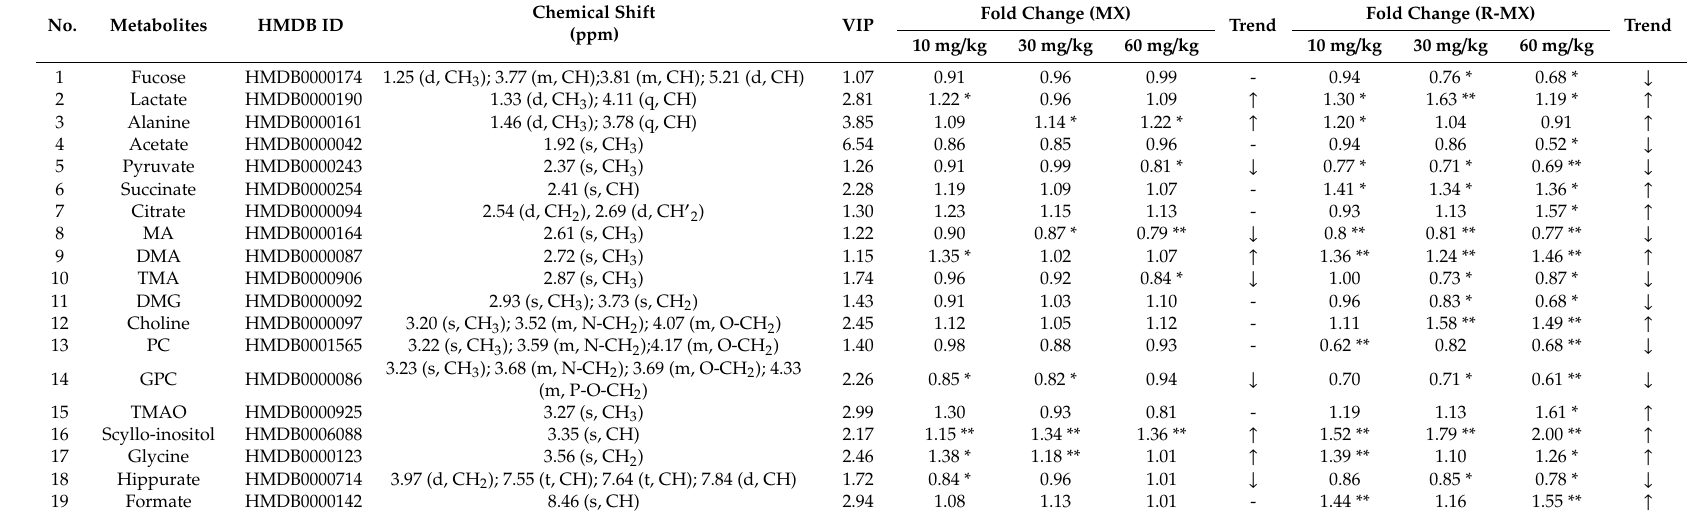
Table 1. Alterations of urine metabolites induced by rac -metalaxyl and metalaxyl-M in